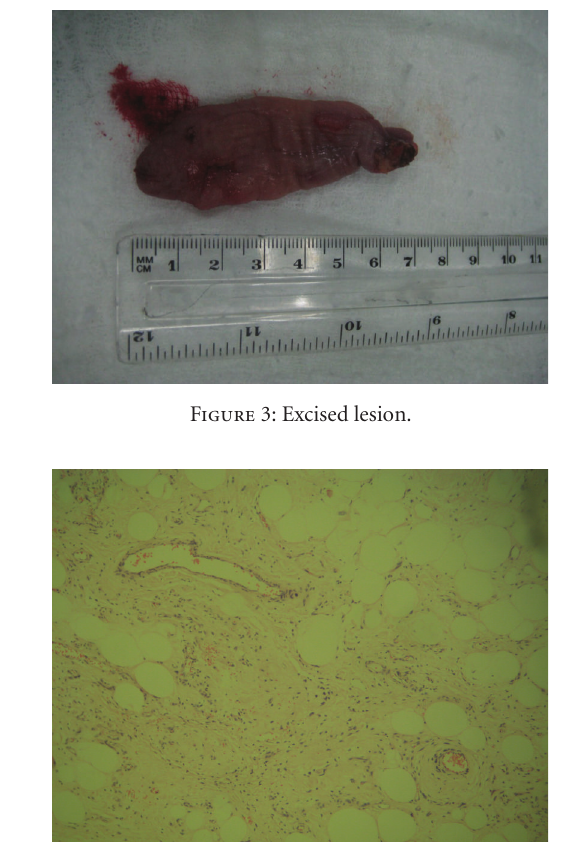
Figure 2: Intraoperative image.